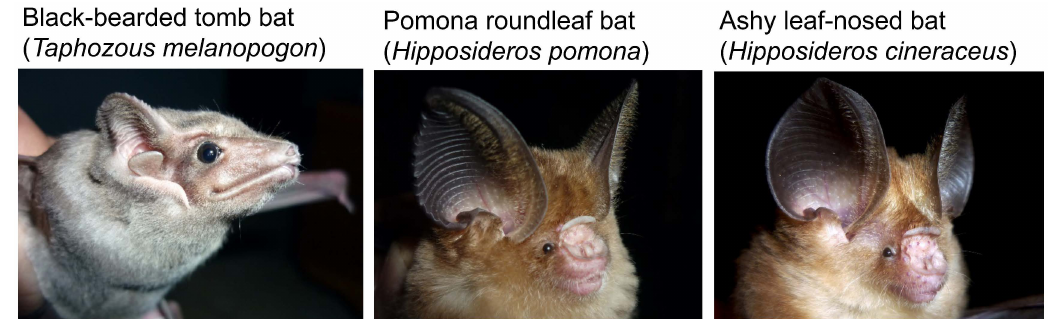
Figure 1. Insectivorous bats harboring mobatviruses in Myanmar and Vietnam. The black-bearded tomb bat ( Taphozous melanopogon ) (family Emballonuridae) hosts L á ib¯ın virus, and the Pomona roundleaf bat ( Hipposideros pomona ) and ashy leaf-nosed bat ( Hipposideros cineraceus ) (family Hipposideridae) hosts Xu â n S ơ n virus.